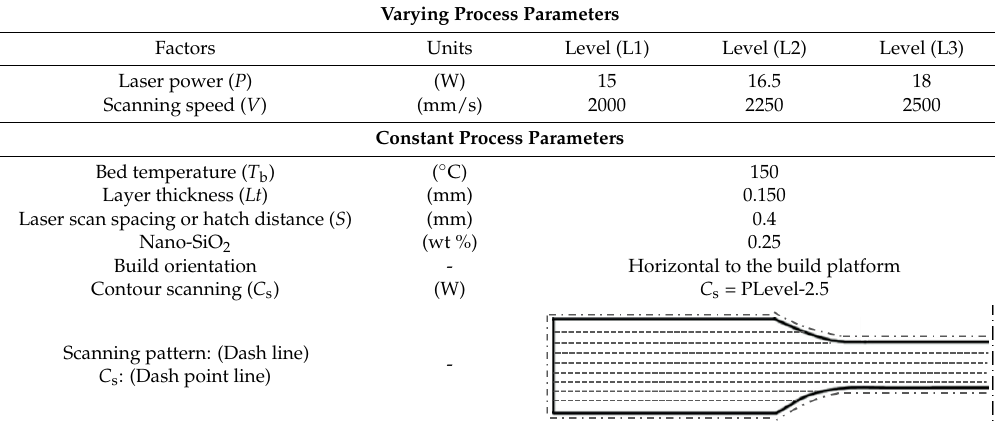
Table 1. Factors and levels for the full factorial DOE